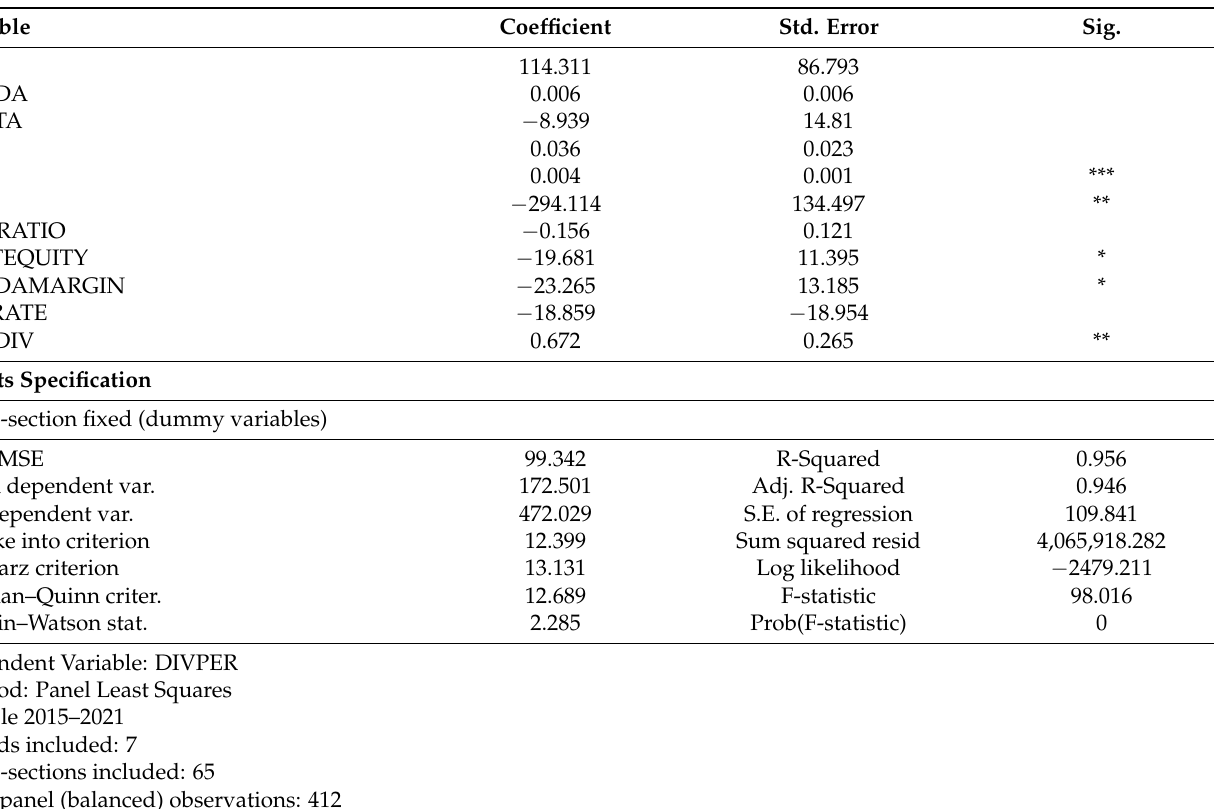
Table 7. Determinants of dividend payout of regular dividend